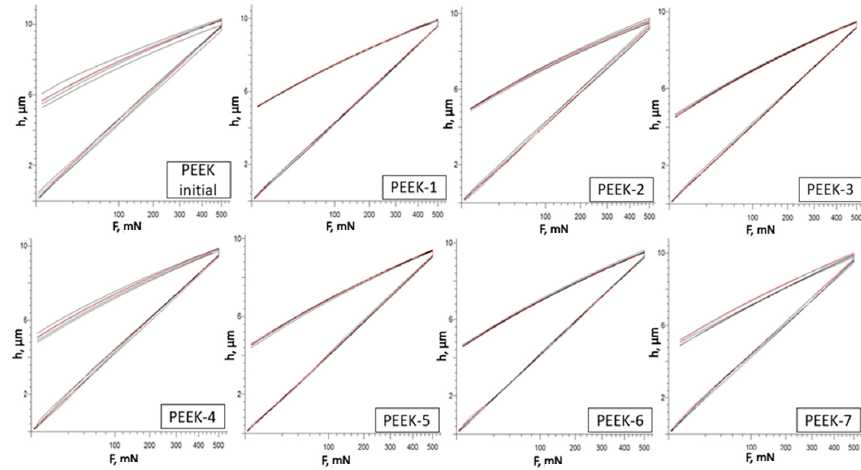
Figure 4. Load–displacement data for PEEK samples.